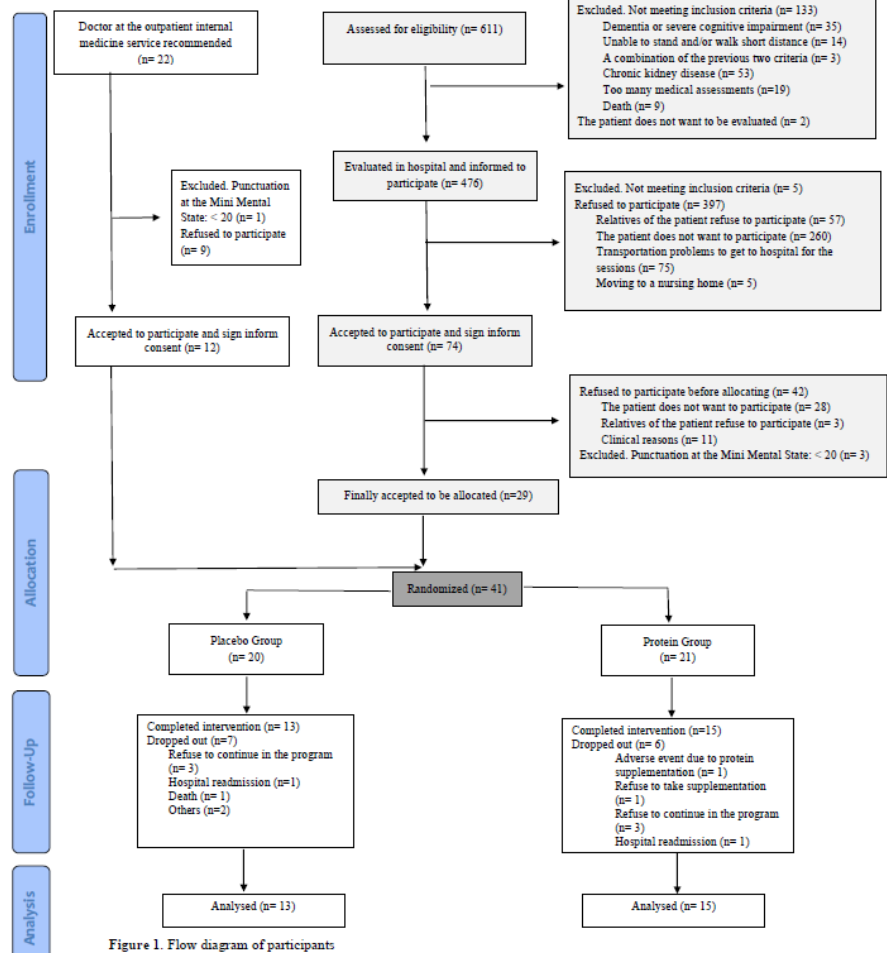
Figure 1. Flow Diagram of participants.